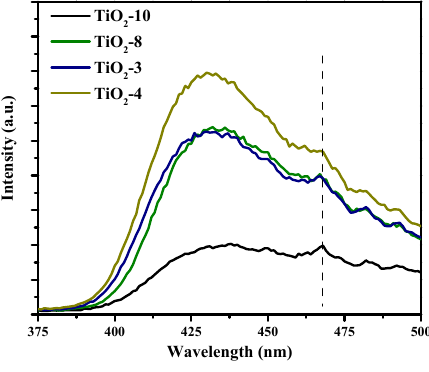
Figure 10. Photoluminescence of hard templated mesoporous TiO 2 .